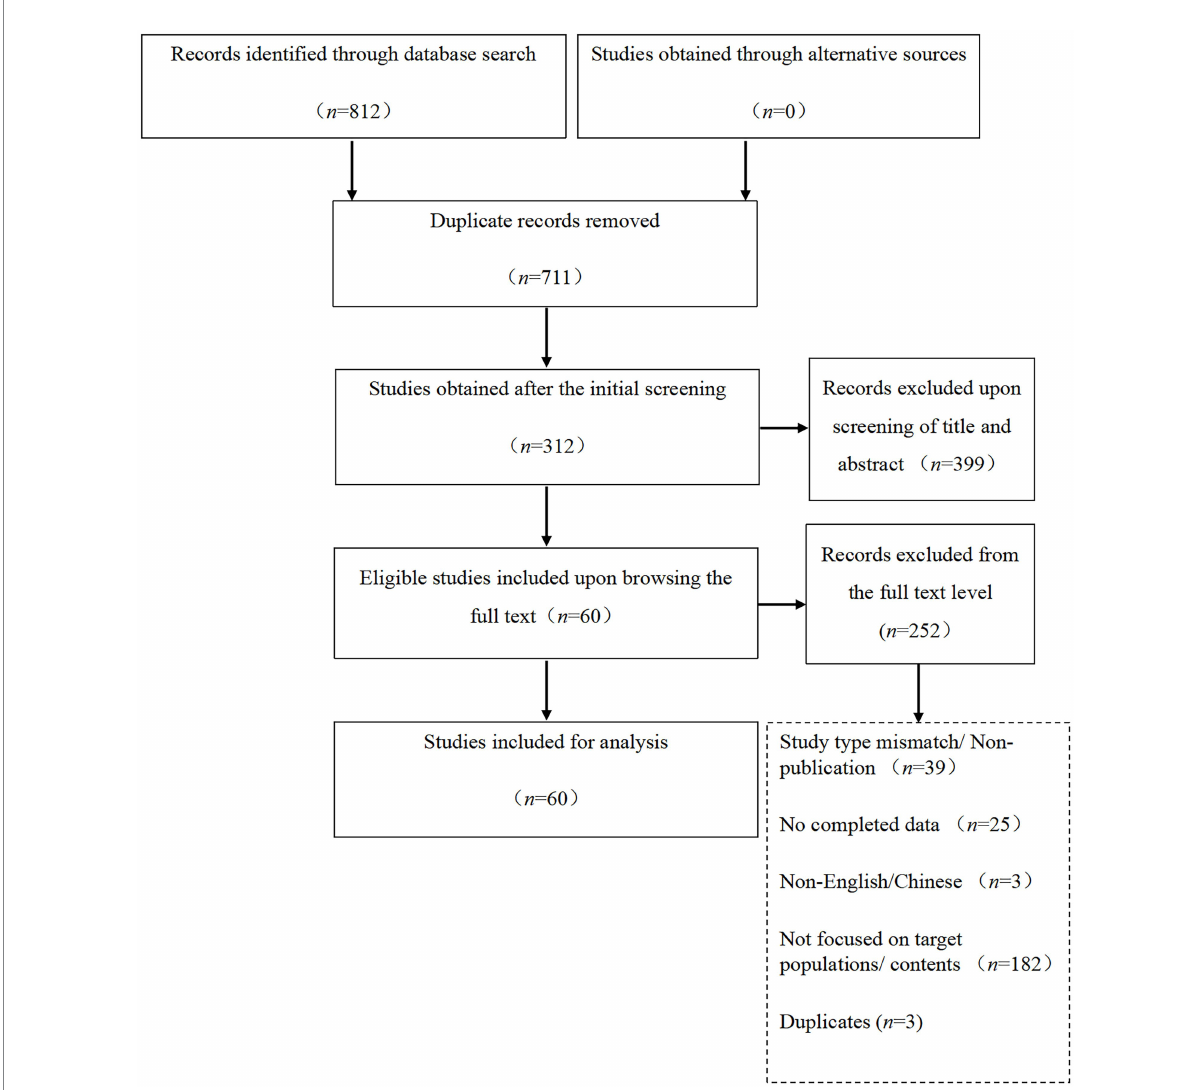
FIGURE 1 Flow chart of the study screening process. The studies obtained from each database are as follows: PubMed ( n = 16), Web of Science ( n = 5), PsycINFO ( n = 22), CINAHL ( n = 12), China National Knowledge Infrastructure ( n = 3), Wanfang Data ( n = 2), and the Chinese Biomedical Literature Database ( n =